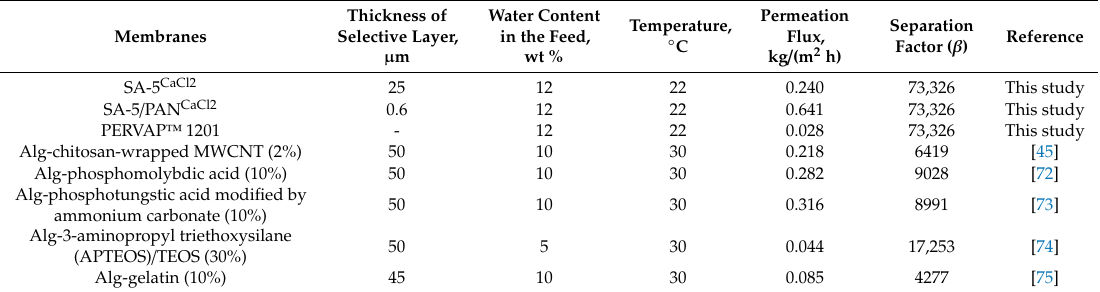
Table 7. Comparison of transport properties of SA-based membranes for isopropanol dehydration. Thickness of Membranes Selective